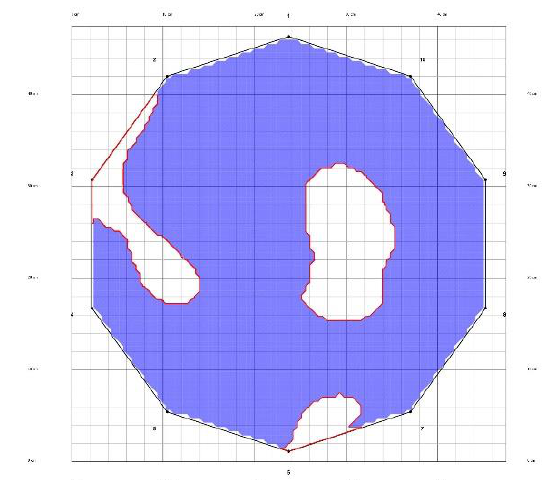
Figure 17 Stress wave pseudo image of D2 pillar of the